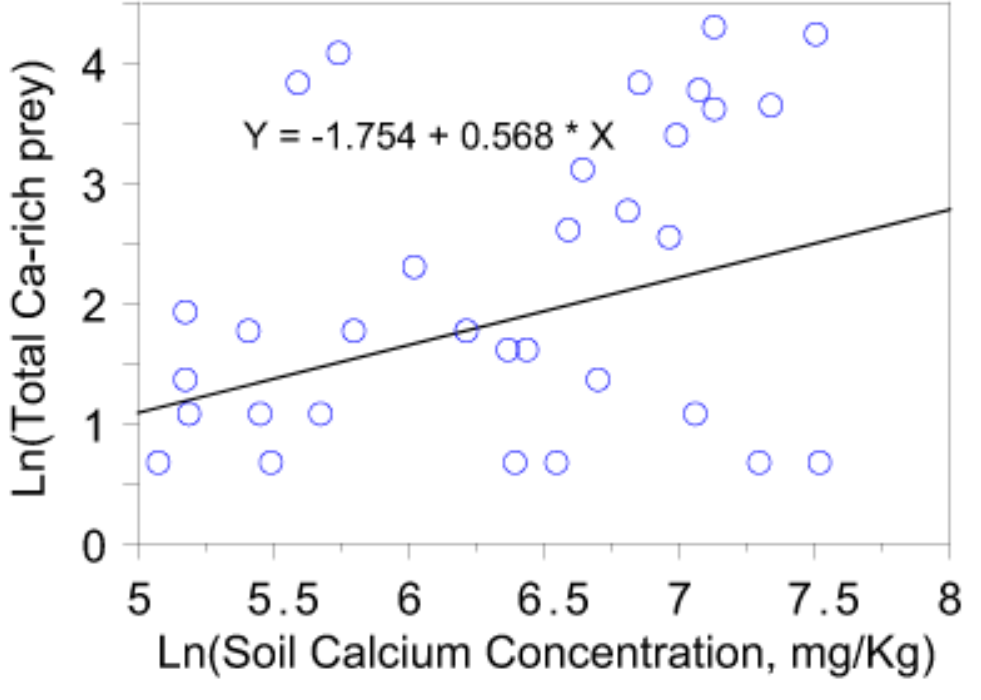
Fig. 5. The relationship between the log-transformed total number of calcium-rich prey at each site and the soil pH, measured in water. Ordinary least-squares regression yielded a highly significant linear